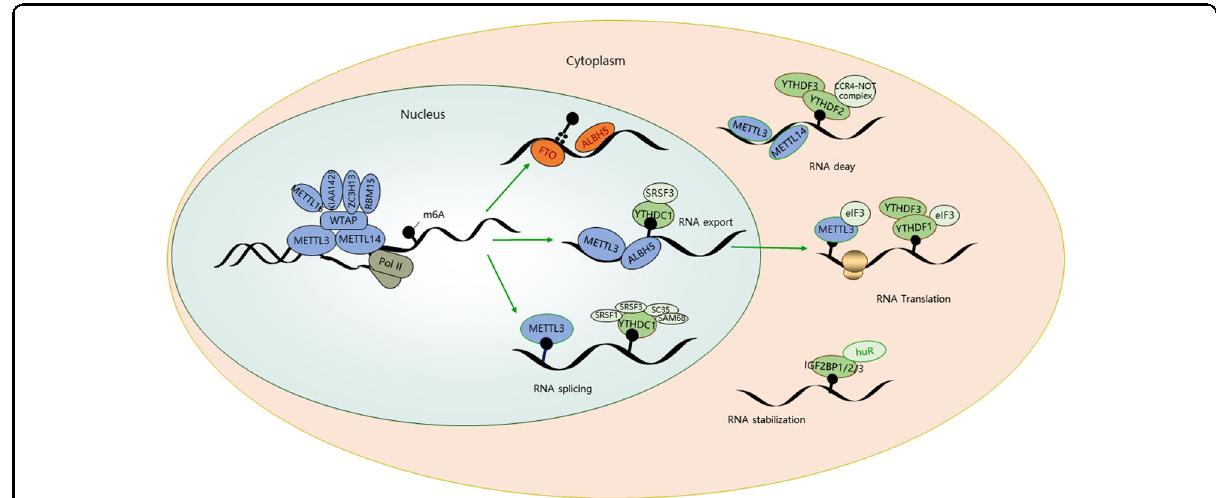
Fig. 1 The m6A mRNA life cycle. The m6A modi fi cation by writer, eraser, and reader. The fi gure depicts various writer (blue), eraser (red), and reader (green) proteins involved in the regulation by m6A modi fi